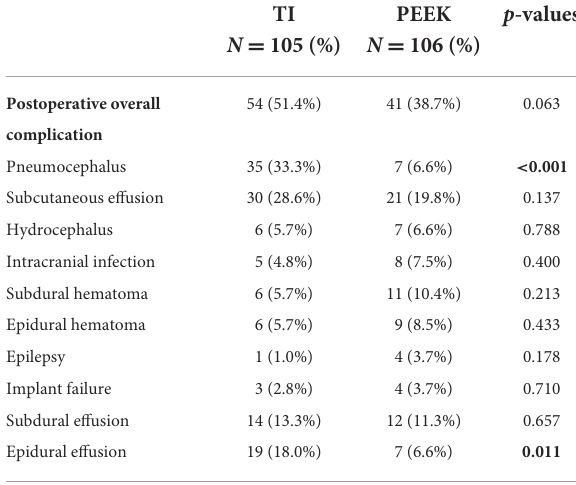
TABLE 3 Postoperative complication between TI group and PEEK